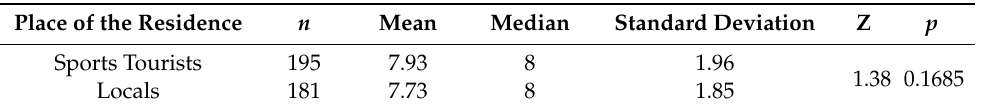
Table 9. The level of intensity of the motivation to undertake PA due to cheering in the 6th Poznan Half Marathon—depending on the place of the